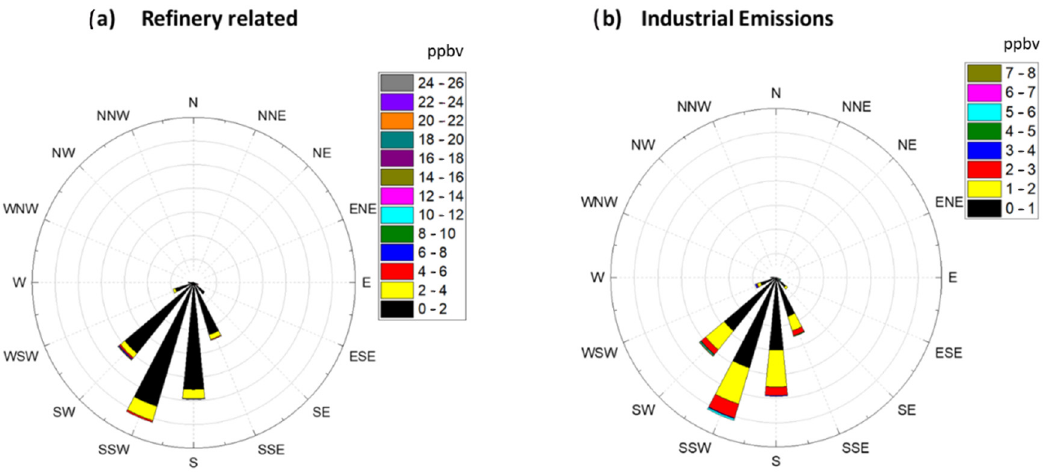
Figure 5. ( a ). Concentration rose plot for Factor 2 (Refinery Related) and ( b ) concentration rose plots for Factor 5 (Industrial Emissions). Values in the legend are in units of ppbv.